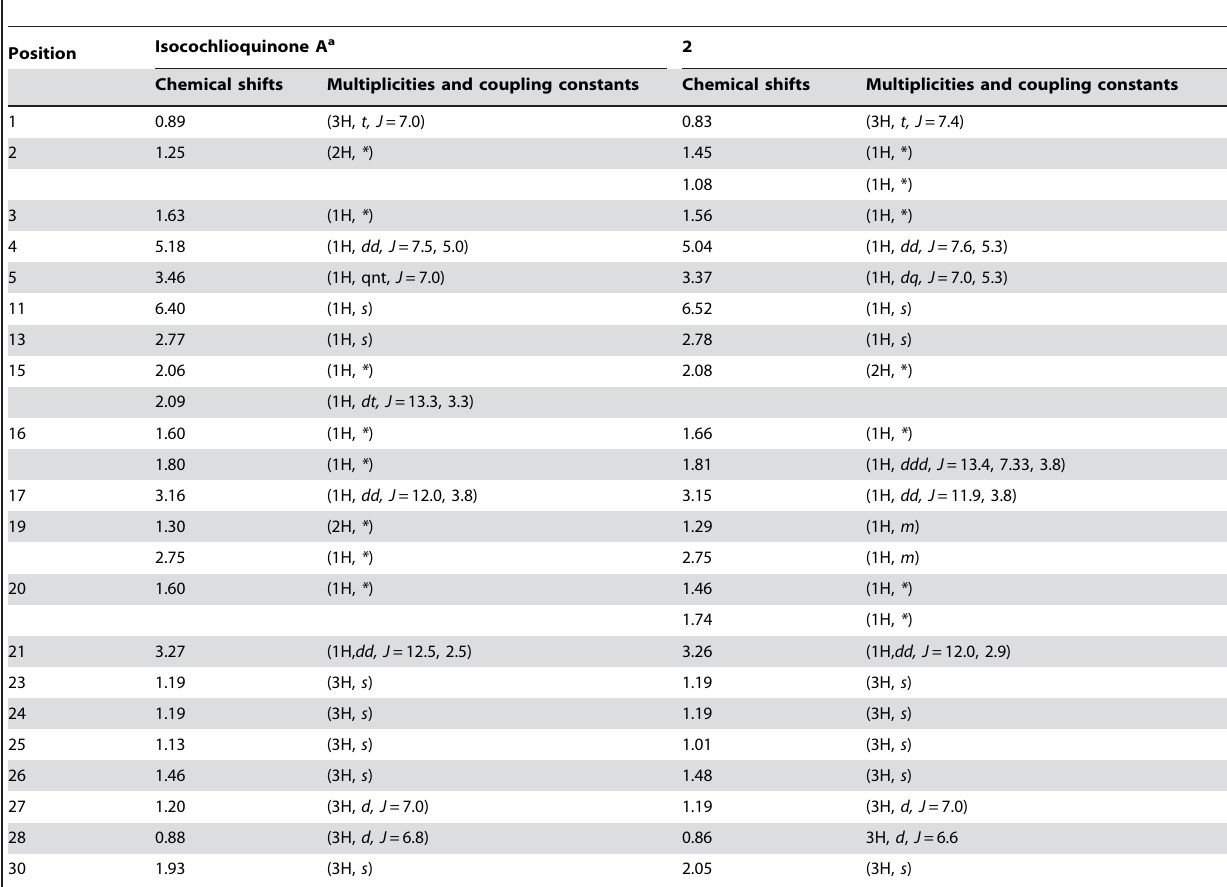
Table 3. 1 H-NMR and HSQC spectral data of 2 and comparison with literature data for isocochlioquinone A.